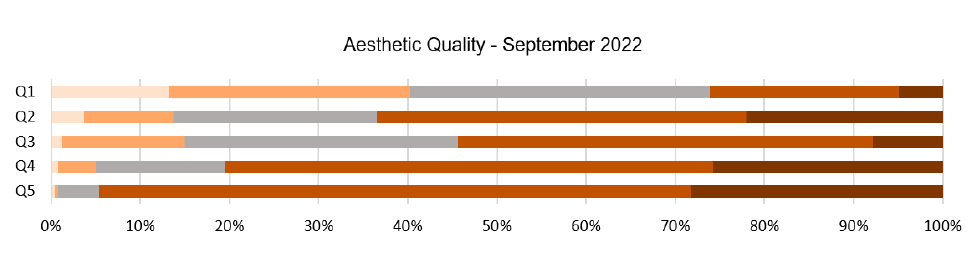
Table 3. Interval data analysis of the Functionality dimension.